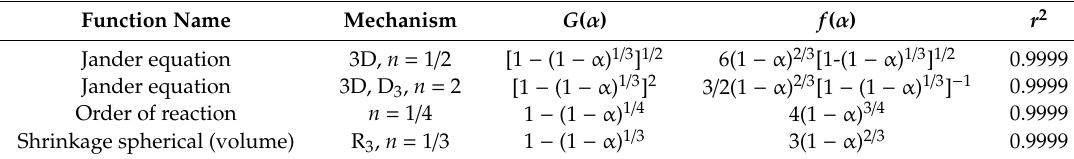
Table 2. The highest correlation coe ffi cients reaction model for lg G ( α )-1 / T fitting liners in 40 forms of the reaction mechanism function obtained by the Šatava–Šest á k